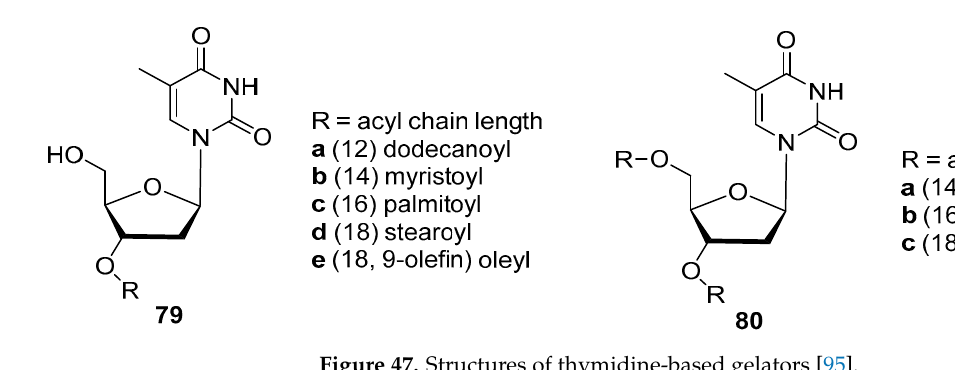
Gels 2021 , 7 , x FOR PEER REVIEW 30 of 64 Figure 47. Structures of thymidine-based gelators [95]. Figure 47. Structures of thymidine-based gelators [95].